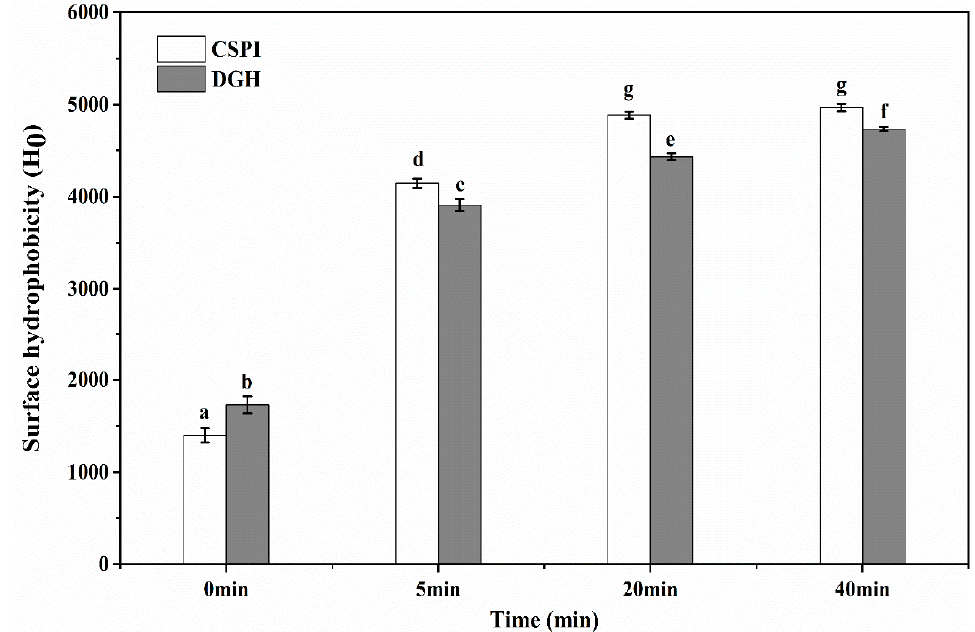
Figure 4. E ff ect of high-intensity ultrasound treatment (20 kHz at 400 W for 0, 5, 20, 40 min) on the surface hydrophobicity of CSPI and DGH. Di ff erent lowercase letters (a, b, c ... ) indicate significant di ff erences between samples at p < 0.05 using Duncan’s test. Error bars represent the standard deviations.